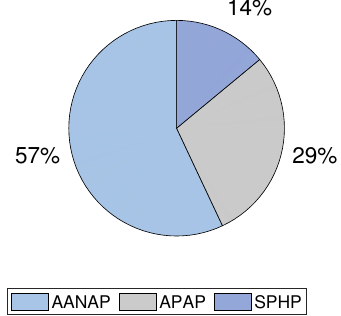
Figure 11. Local hybrid transform implemented on